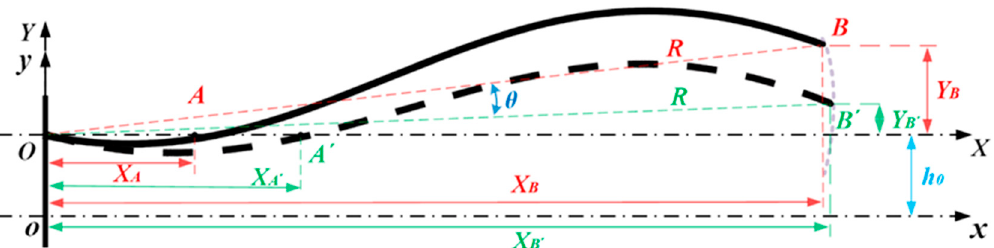
Figure 4. Schematic diagram of the motion structure parameters of gripper’s the single finger. Note: Curve OB is the initial position of the finger; A and A ′ represent the contact point between the constraint part and the finger before and after polymerization, respectively; B and B ′ represent the position of the finger end before and after polymerization, respectively; Arc BB ′ is the motion trajectory of the finger end; θ is the rotation angle of the finger; h 0 is the distance from the finger bottom to the center of the chassis; R is the distance from the finger bottom to end.